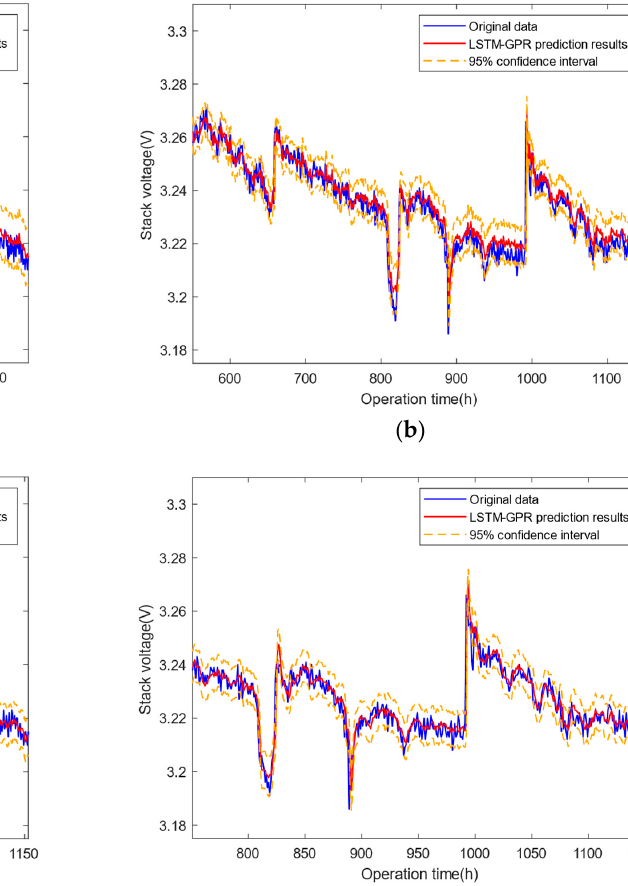
different training phases.